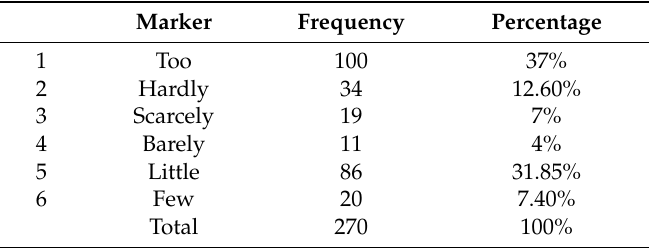
Table 1. Distribution of English negative markers in the corpus.